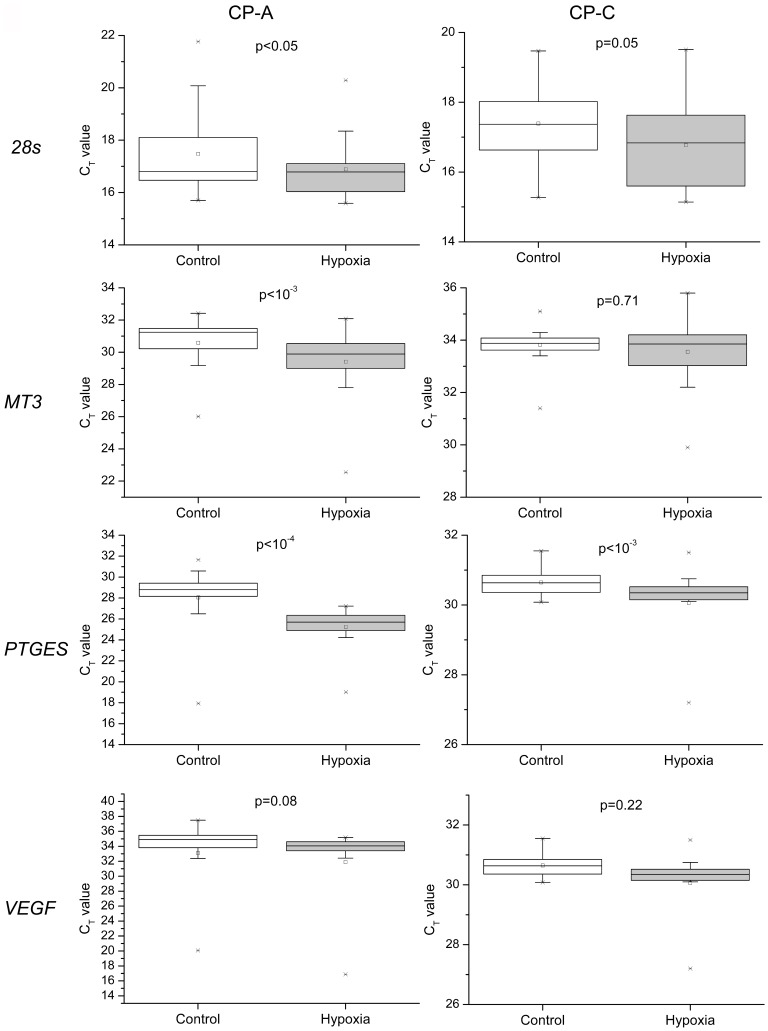
Expression levels of mitochondria and nucleus encoded genes in single control and hypoxia-treated CP-A and CP-C cells Box plots of single-cell gene expression levels and p-values (non-parametric Mann-Whitney test) associated with the differences between normoxic and hypoxic conditions.The box chart shows following statistical values: Open square – mean, solid line – median, upper and lower box lines – the 75th and 25th percentiles, respectively, upper and lower whiskers – the 95th and 5th percentiles, respectively, x – maximal and minimal values.